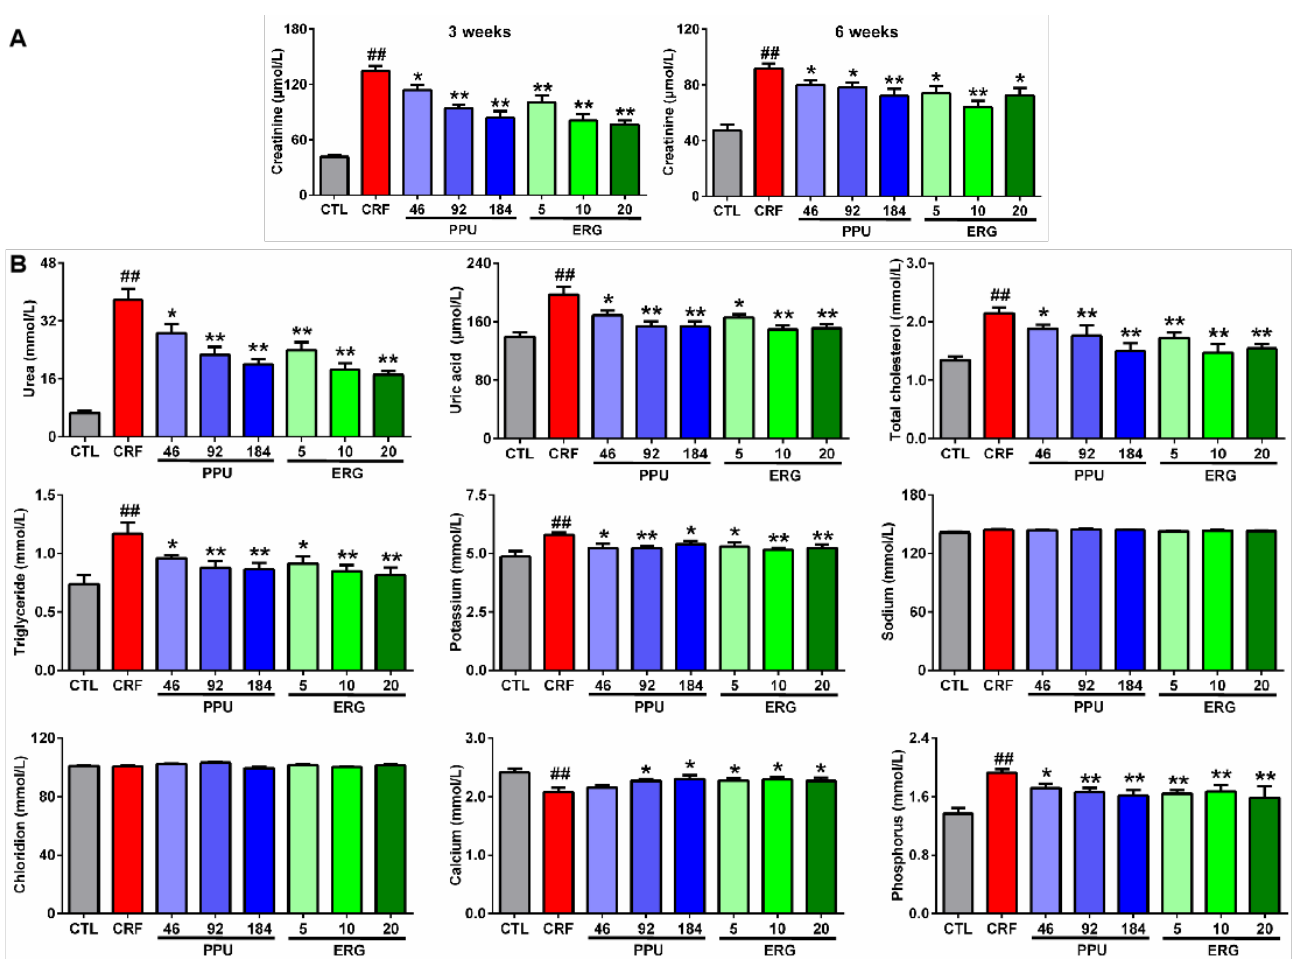
Figure 4. Treatment with Polyporus umbellatus (PPU) and ergone (ERG) improved impaired kidney function on adenine-induced CRF rats. ( A ) Serum creatinine levels in control, CRF, CRF+PPU, and CRF+ERG rats. ( B ) The levels of serum urea, uric acid, cholesterol, triglyceride, potassium, sodium, chloridion, calcium, and phosphorus in control, CRF, CRF+PPU, and CRF+ERG rats. ## — p < 0.01 compared with CTL (control) rats; *— p < 0.05, **— p < 0.01 compared with CRF rats.